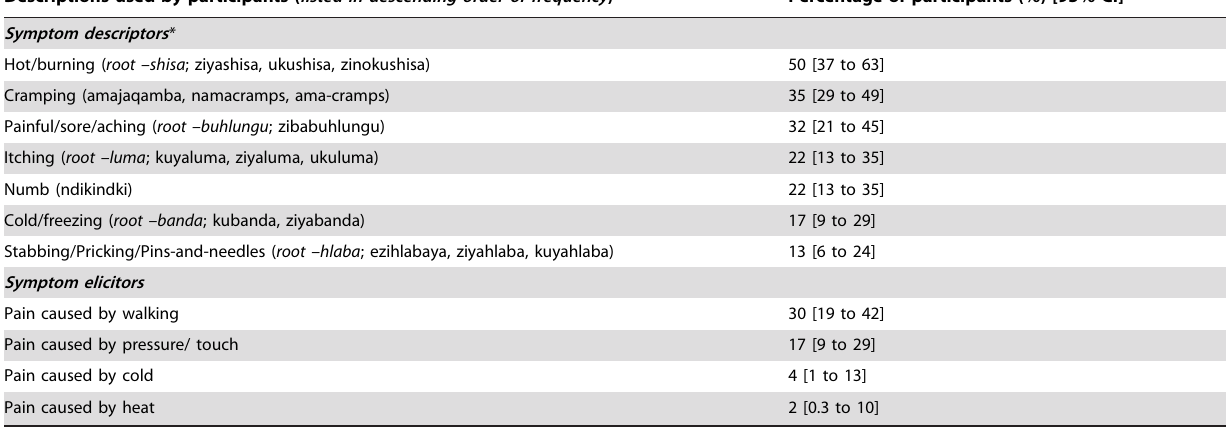
Table 3. English translation of isiZulu terms (in parentheses) spontaneously given by participants to describe their neuropathy